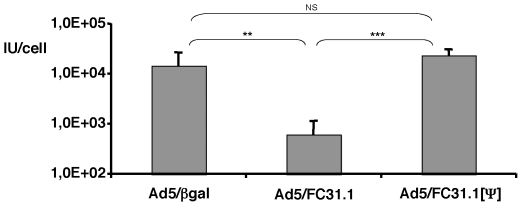
Effect of a second packaging signal in attB-Ad
production.Viral production in IU/cell of Ad5/FC31.1, Ad5/FC31.1[ψ]
and Ad5/βgal at 36 hpi. in HEK293 cells. Titering was performed in
triplicate in HEK-293 cells. Asterisks refers to statistical
significance: ** p<0,01; *** p<0,001;
NS = not significant).